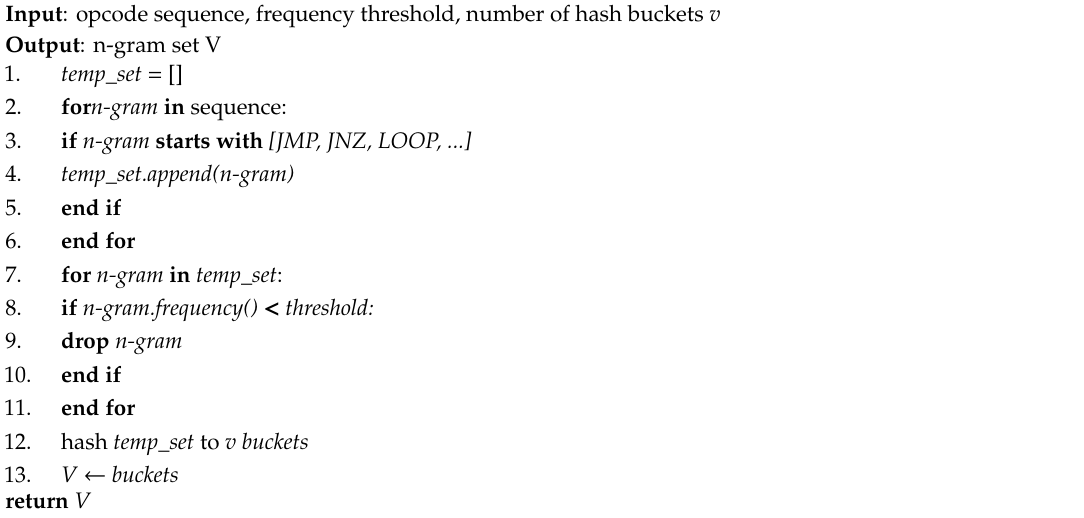
Algorithm 2. The proposed CTIB-n-gram